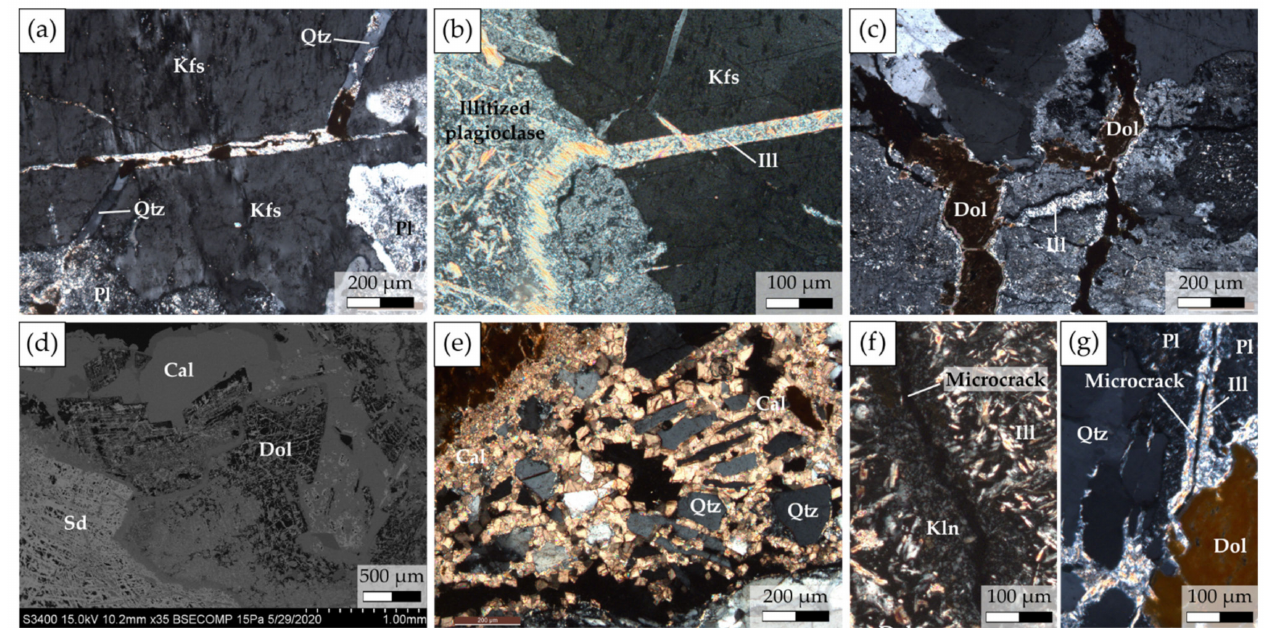
Figure 6. ( a ) Photomicrograph of a quartz veinlets intersected by an illite veinlets under optical microscope in polarized– analyzed light. ( b ) Photomicrograph showing an illite vein crosscutting K-feldspar and illitized plagioclase under optical microscope in polarized–analyzed light. ( c ) Back-scattered image showing the different phases presented in ( b ). ( c ) Pho- tomicrograph showing dolomite intersecting illite under optical microscope in polarized–analyzed light. ( d ) Back-scattered image of a dolomite, siderite, and calcite showing their chronology. ( e ) Hydraulic fracturing with calcite precipitating around clasts of quartz placed like a fan under optical microscope in polarized–analyzed light. ( f ) Photomicrograph under optical microscope in polarized–analyzed light of a microfracture intersecting an altered plagioclase which borders are made of pure kaolinite, whereas the plagioclase was recrystallized into kaolinite and illite. ( g ) Photomicrograph under an optical microscope in polarized–analyzed light, showing illite developing on the walls of an open microfracture and dolomite filling this open